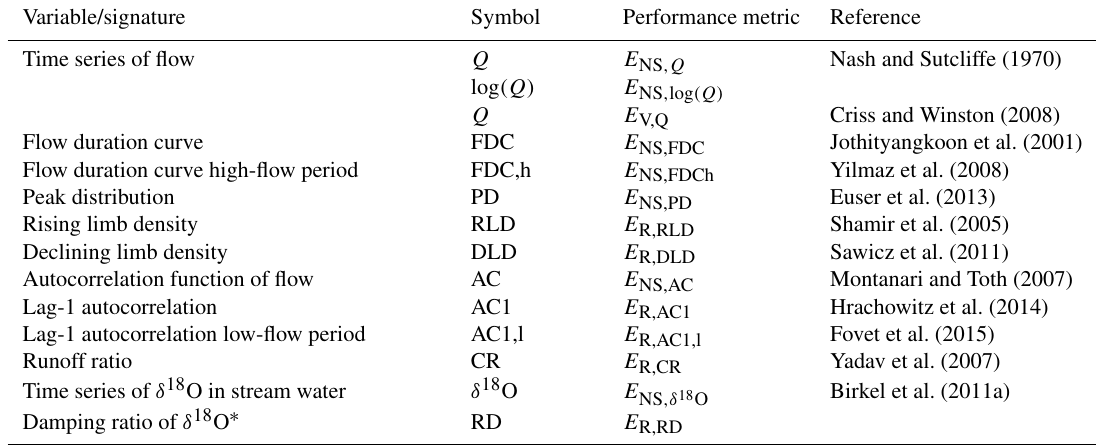
Table 3. Signatures of flow and δ 18 O and the associated performance metrics used for model calibration and evaluation. The performance metrics used include the Nash–Sutcliffe efficiency ( E NS ), the volume error ( E V ) and the relative error ( E R